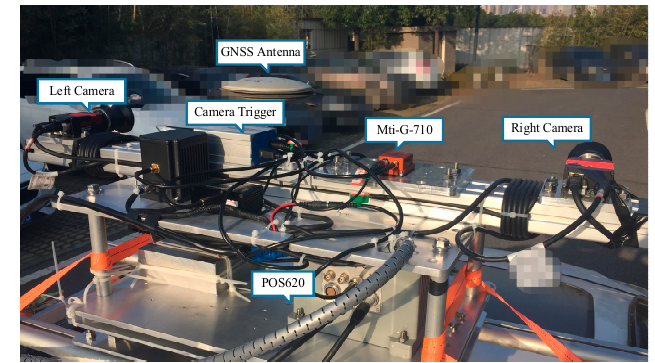
Figure 2. Our sensor platform.